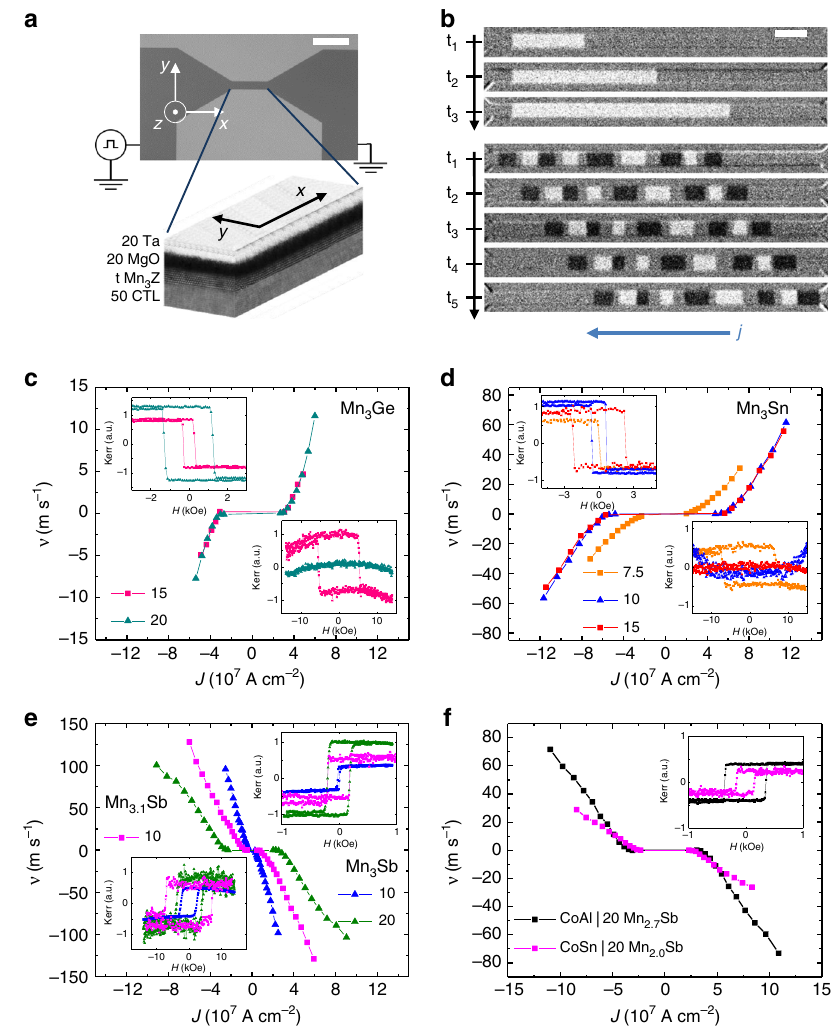
Fig. 3 Mn x Z (Z = Ge, Sn, Sb) DW motion with CoGa, CoSn, and CoAl CTL. a Optical microscopy image of a nanowire device showing the contact pads at both ends (the length of the scale bar is 25 μ m). A 3D structure view of the wire shows the layer stack (thicknesses are in Å). b Kerr images of a single DW with each frame taken after three 100 ns current pulses (top), and nine unequally spaced DWs with each frame taken after one 100 ns current pulse (lower part) for a 20 Å-thick Mn 3 Sb nanowire. The direction of current fl ow, j , is indicated by the arrow. The current density is J ¼ 4 : 7 ´ 10 7 Acm (cid:2) 2 and the length of the scale bar is 5 μ m. c – e DW velocity versus current density for Mn 3 Ge, Mn 3 Sn, and Mn 3 Sb/Mn 3.1 Sb nanowires of different thicknesses with CoGa CTL. f DW velocity versus current density for 20 Å Mn x Sb for CoAl and CoSn CTLs. The top inset within each graph shows the corresponding out-of-plane P- MOKE loops. Bottom inset shows the in-plane P-MOKE nanowire length. Results are shown in Fig. 4a – c for H x and in Fig. 4d – f for H y for the ↑↓ and ↓↑ DW con fi gurations for 20 Å Mn 3 Ge, 10 Å Mn 3 Sn, and 20 Å Mn 3 Sb on CoGa CTL. The dependence on H y is independent of the DW con fi guration whereas the dependence on H x is a mirror image for the two DW con fi gurations. These results, re fl ecting the chiral DW motion, are evidence for a DMI fi eld H DM along the x direction which sets Néel type DWs. As J is increased from zero, the volume spin torque causes the moments in the domain wall to rotate out of the plane of the nanowire. This gives rise to a damping torque ( ɑ M × d M /d t ) along y that results in a precessional motion of the DW along the nanowire. At the same time the combination of the DMI and H x applied fi eld gives rise to a torque that counteracts the volume spin torque (see Supplementary Fig. 21). The DW